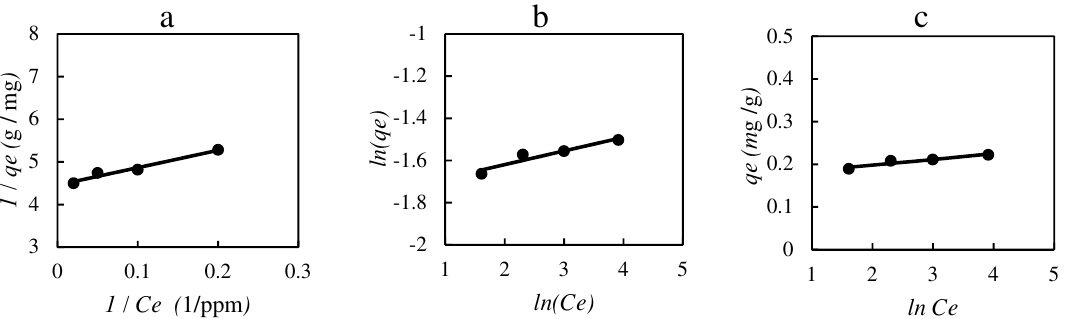
Figure 12. The isotherms for adsorption of the Congo red using TiO2@PVA nanocomposite: ( a ) Langmuir, ( b ) Freundlich, ( c ) Temkin. Isotherm